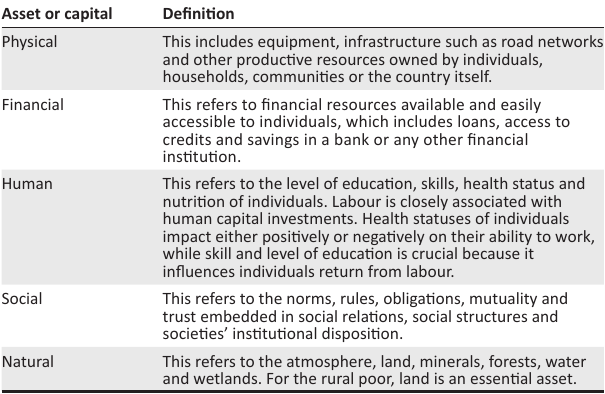
TABLE 2: Definition of the five fundamental assets or capital for individuals, households and communities.